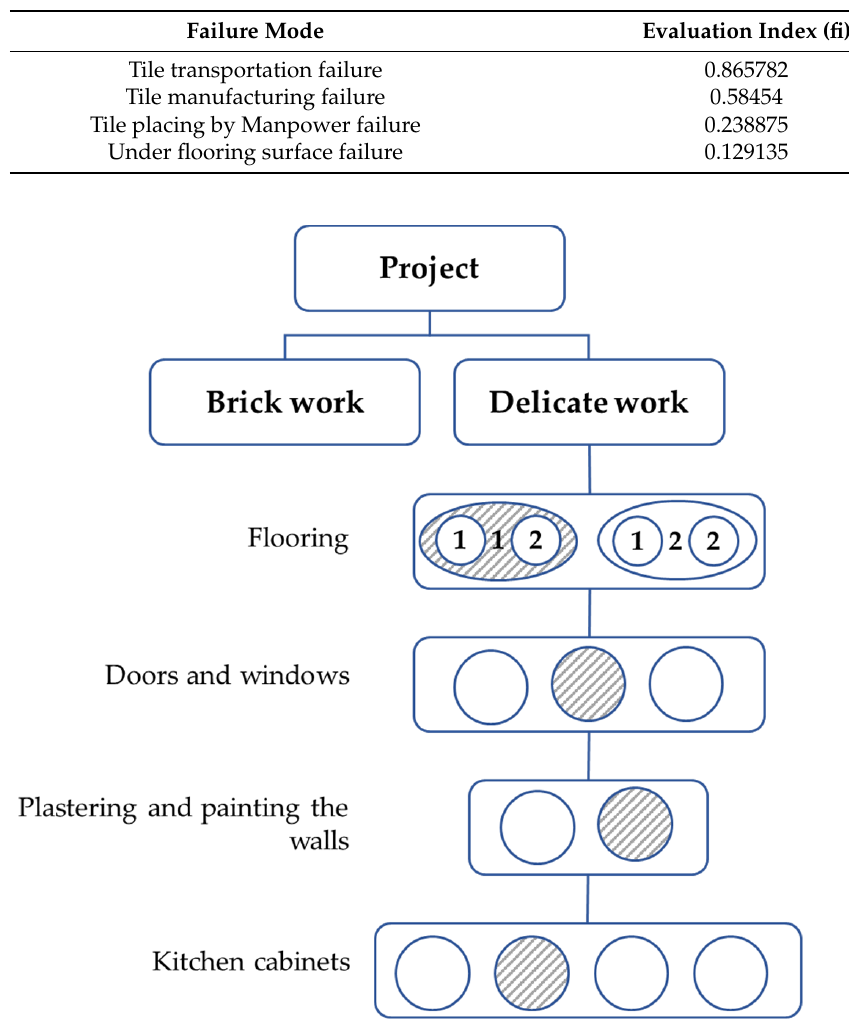
Figure 10. An initial project configuration.